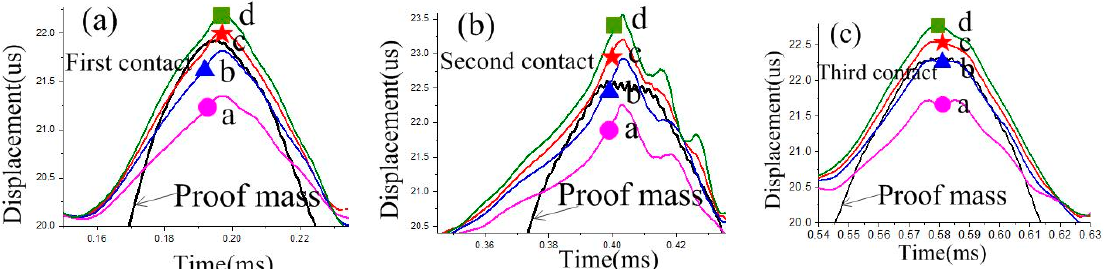
Figure 9. The response curves of points a, b, c d of the first, second and third contact. ( a ) First contact. ( b ) Second contact. ( c ) Third contact.